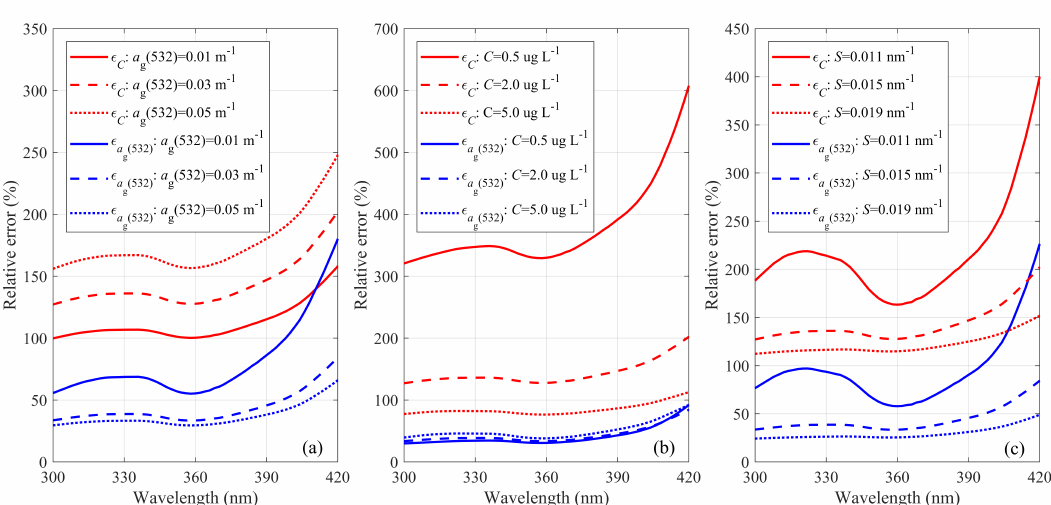
Figure 5. Relative errors of chlorophyll (red lines) and CDOM absorption (blue lines) in ( a ) di ff erent a g (532) (Case 1–3 in Table 1); ( b ) di ff erent C (Case 1, 4 and 5 in Table 1); ( c ) di ff erent S (Case 1, 6 and 7 in